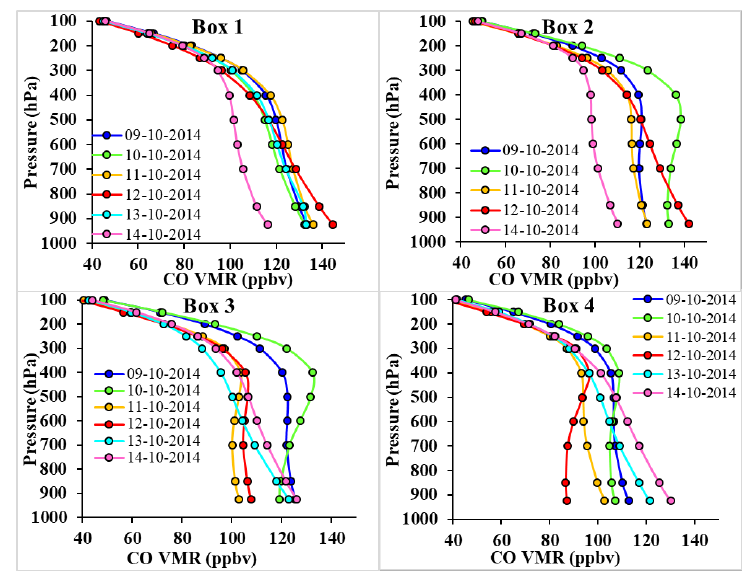
Figure 11. Vertical profiles of CO volume mixing ratio for 9 – 14 October 2014.